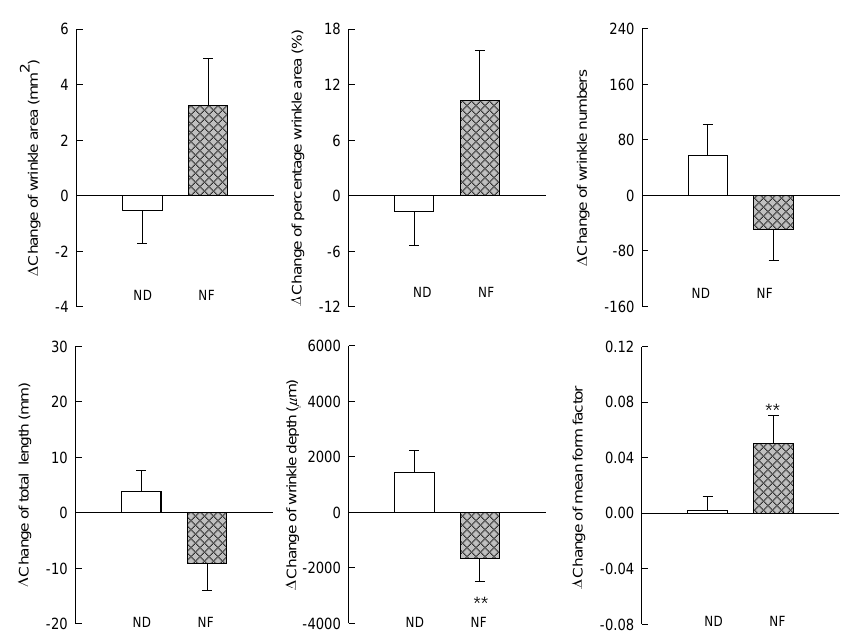
Figure 3. Effects of serum cosmetics containing GOS on wrinkle index from baseline after 8 weeks of treatment in healthy adults. The asterisks indicate significant differences (** p < 0.01) between the NF and the ND groups at the indicated week. The p of two-sided independent t -test method was displayed, and all data are reported as mean ± standard error of the mean. ND (control serum); NF (cosmetic serum containing GOS).